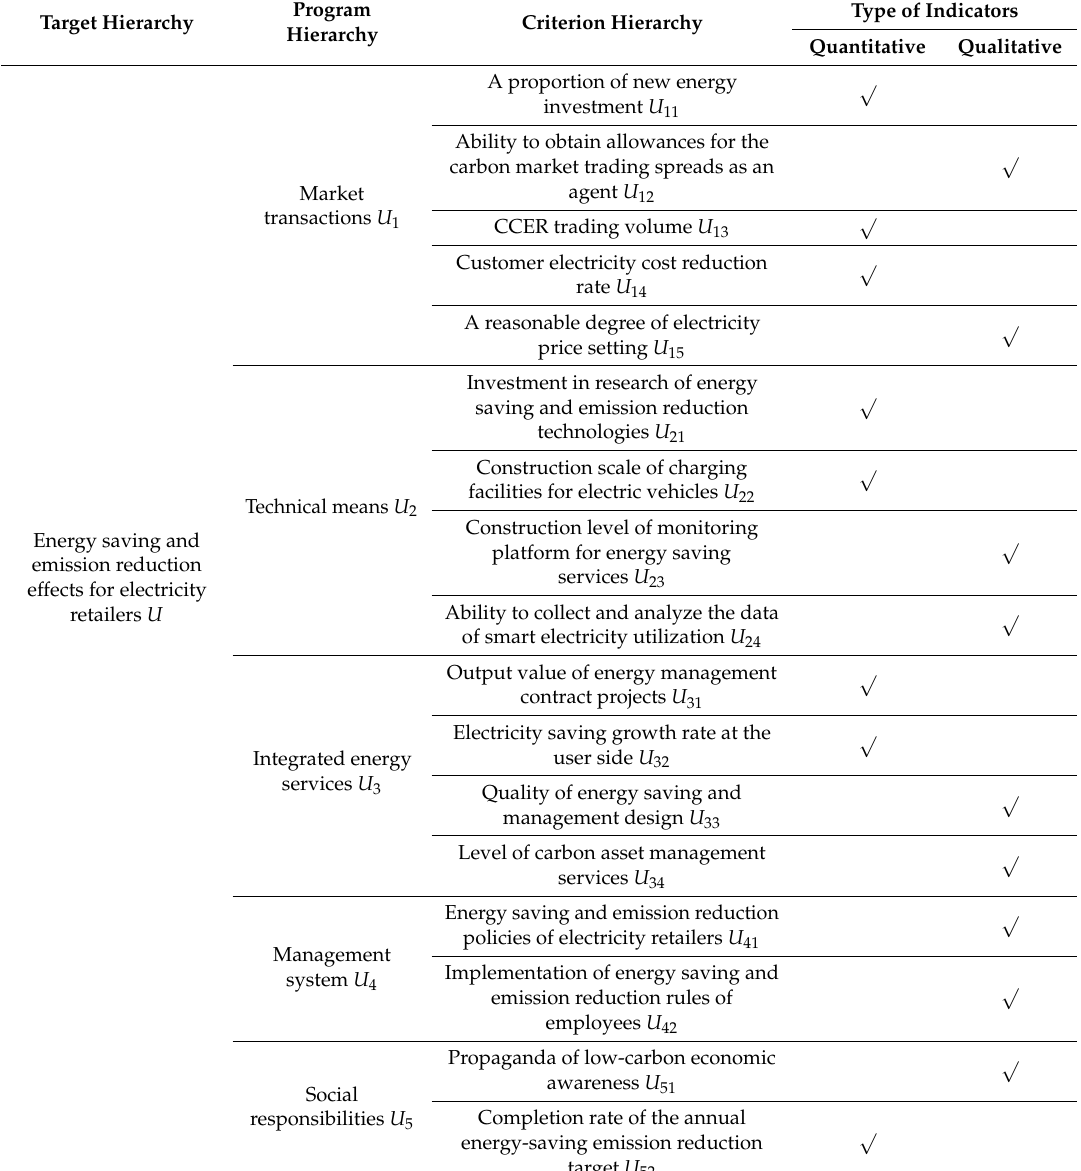
Table 1. Hierarchy division of the evaluation indicator system of energy saving and emission reduction effects for electricity retailers in